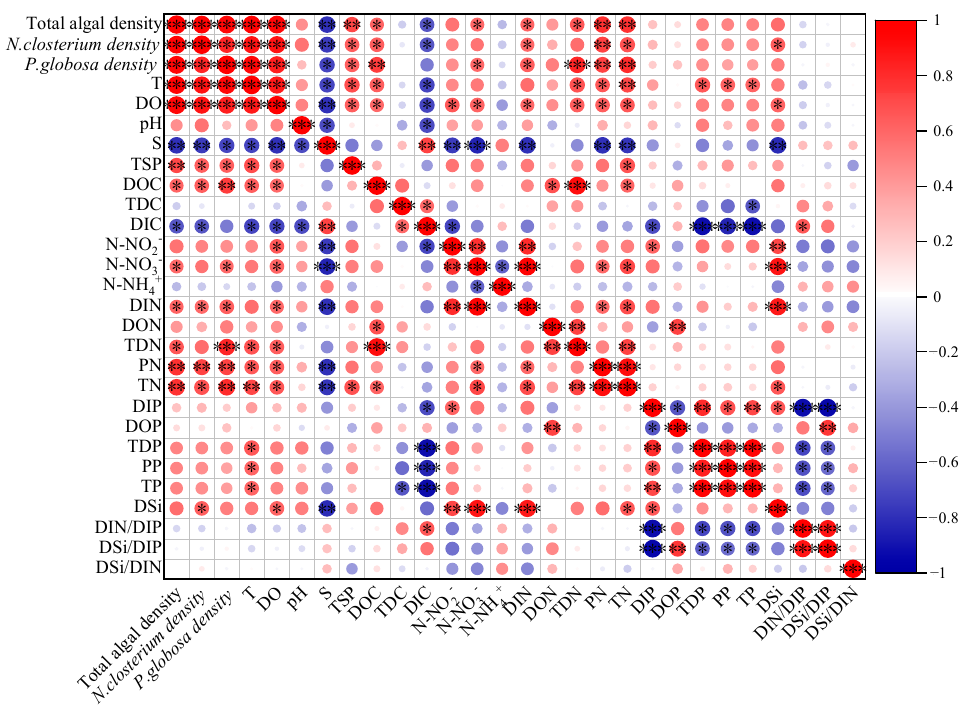
Figure 6. Relationships among nutrients, carbon, and phytoplankton during spring algal bloom (n = 12, * p < 0.05 ** p < 0.01 *** p < 0.001).